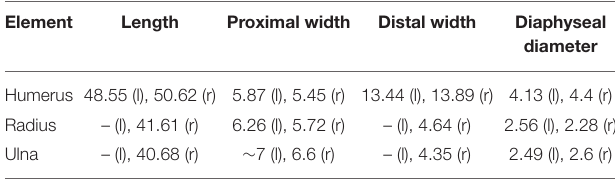
TABLE 5 | Measurements (in mm) of the forelimb bones of PIMUZ T